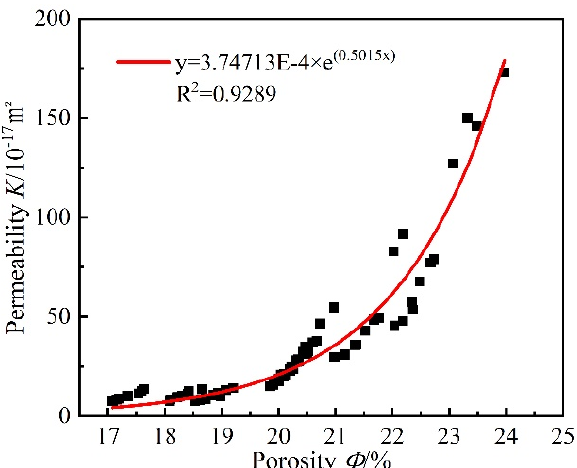
Figure 7. Relationships between porosity and gas permeability (Black square: experimental data).